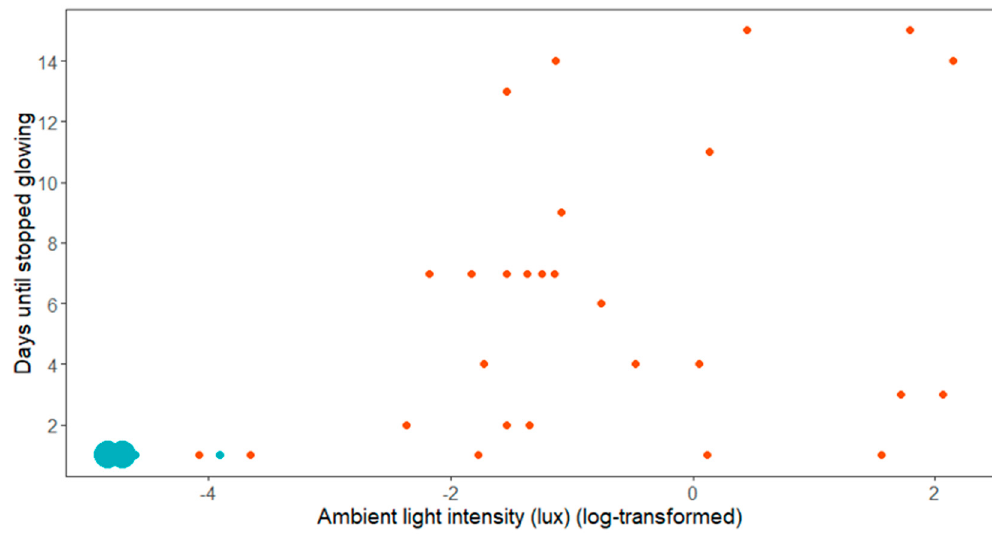
Figure 2. Observed time until mating (using cessation of glowing as a proxy) in relation to light conditions. Blue dots are the females in dark areas and red dots are the females in illuminated areas. The size of the dots reflects the number of individuals. Note that not all females were monitored until they ceased glowing. The two large dots in the lower left corner represent 22 females (N tot = 51).